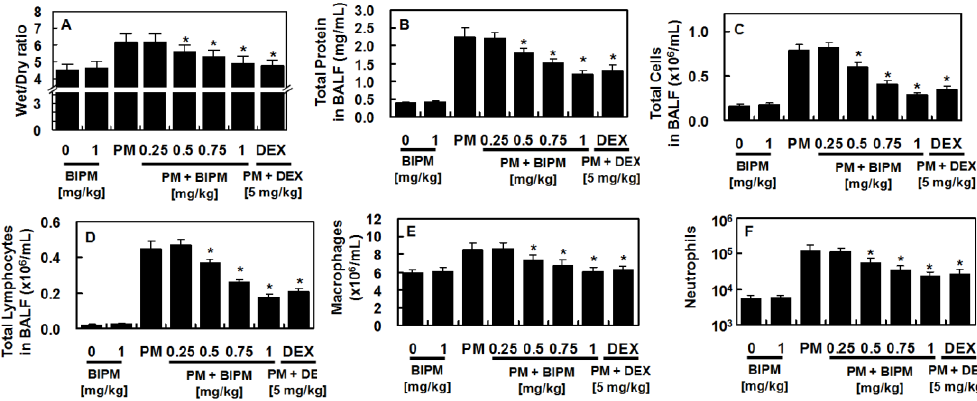
Figure 2. Effects of BIPM on particulate matter (PM) c -induced lung damage. The biapenem (BIPM) and dexamethasone (DEX) groups were injected intravenously 30 min after being intratracheally challenged with PM 2.5 (10 mg / kg in 50 µ L of saline). The mice were then sacrificed 24 h post-PM 2.5 -injection and the lung tissue and bronchoalveolar lavage fluid (BALF) were harvested. The effects of various concentrations of BIPM or DEX on ( A ) the wet/dry (W/D) ratio, ( B ) total cells, ( C ) total protein, ( D ) lymphocytes, ( E ) macrophages, and ( F ) neutrophils in the BALF were assessed. The values represent the mean ± SD of three independent experiments. * p < 0.01 versus the PM-challenged group.